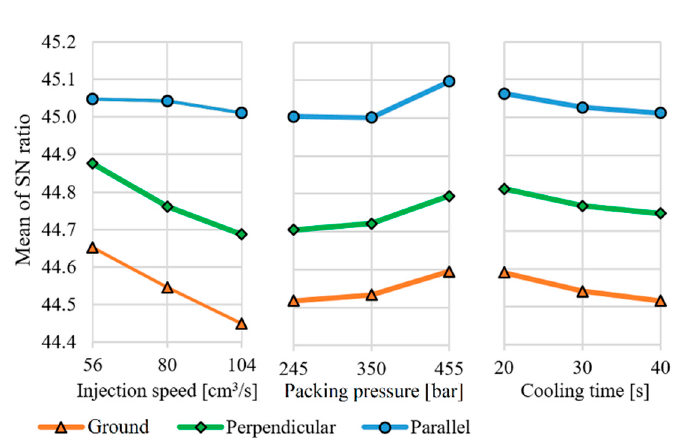
Figure 5. Main effects plot for SN ratios. Three-point bending. Table 6. Response table of means—three-point bending test, with different surface-structured specimens. Ground